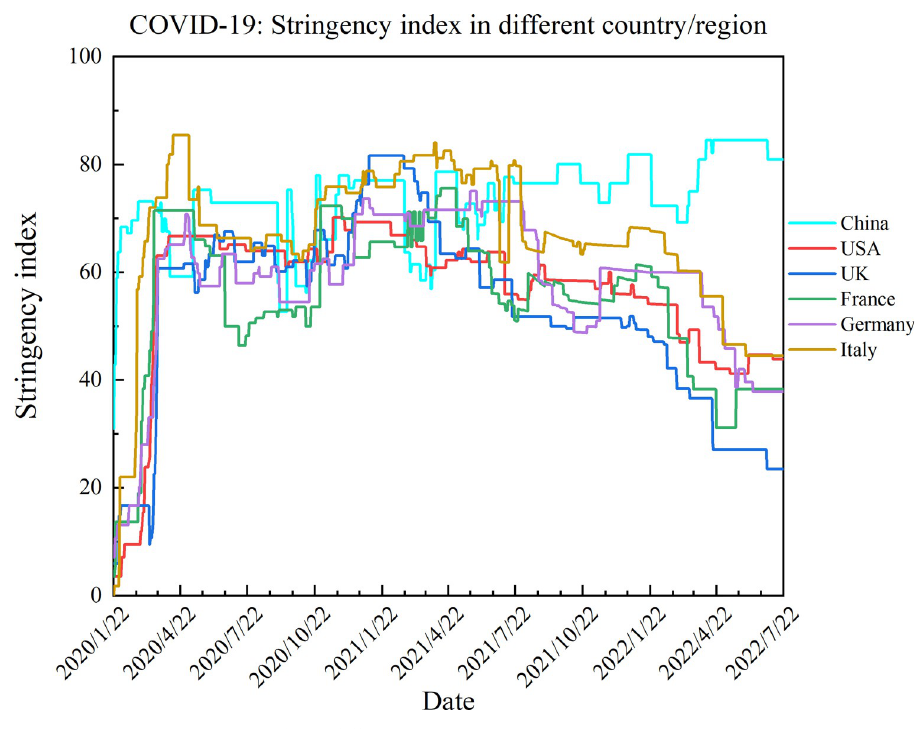
Fig 1. COVID-19: Stringency index in different